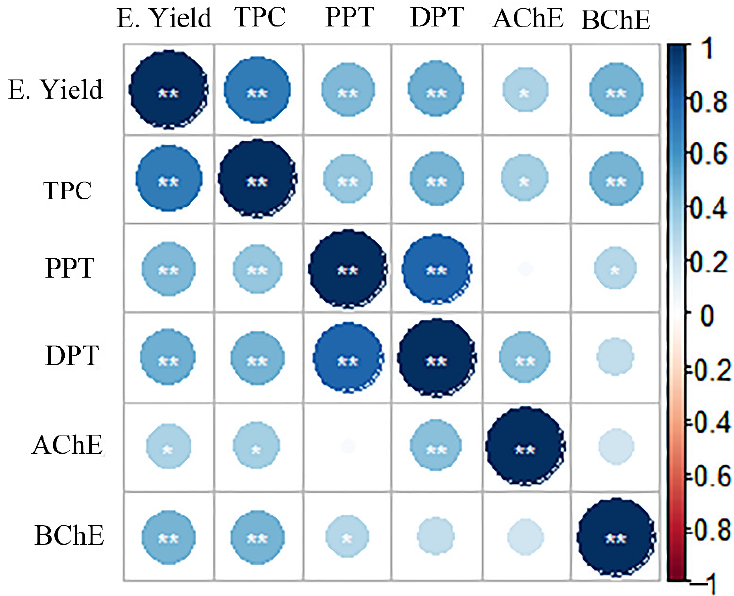
Figure 4. Relationship between bioactive compounds and biological activities in the needles of J. sabina. “*”: p < 0.05; “**”: 0.01 < p < 0.05; E. yield: the extraction yield; TPC: total phenol content; PPT: podophyllotoxin; DPT: deoxypodophyllotoxin; AChE/BChE: the anti-cholinesterase activity values of J. sabina extracts.